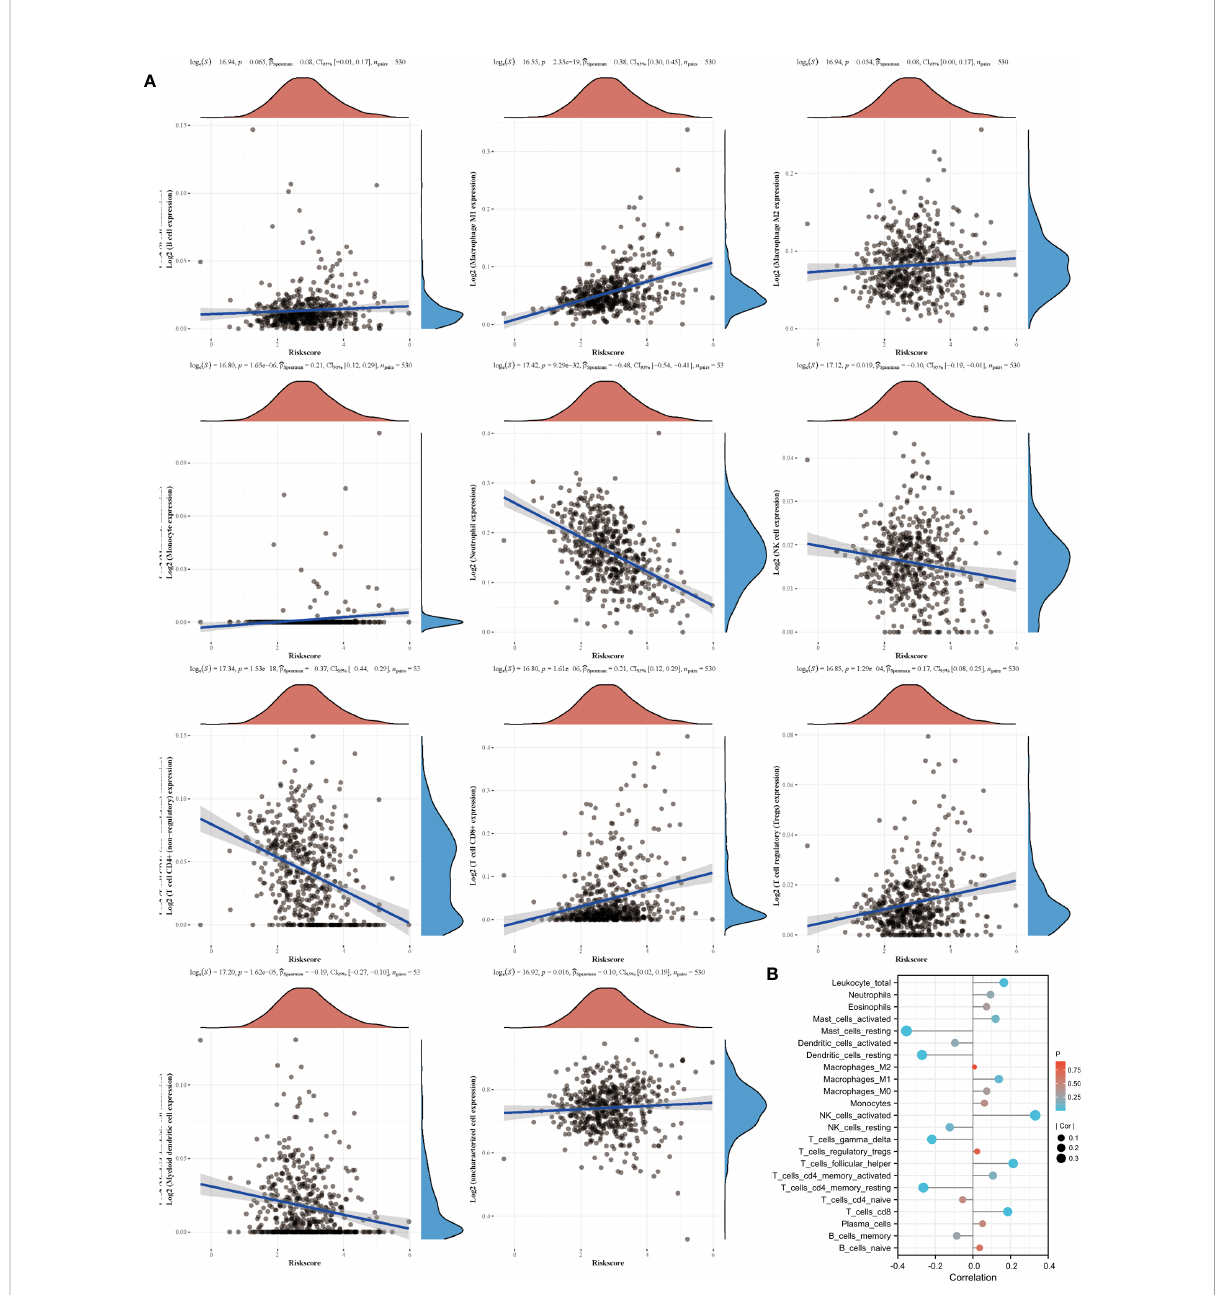
FIGURE 5 Signature and immune cell in fi ltrates. (A) Correlation of immune cell in fi ltrates with risk score according to TCGA datasets. (B) Immune cell in fi ltration in patients receiving nivolumab therapy of two clinical